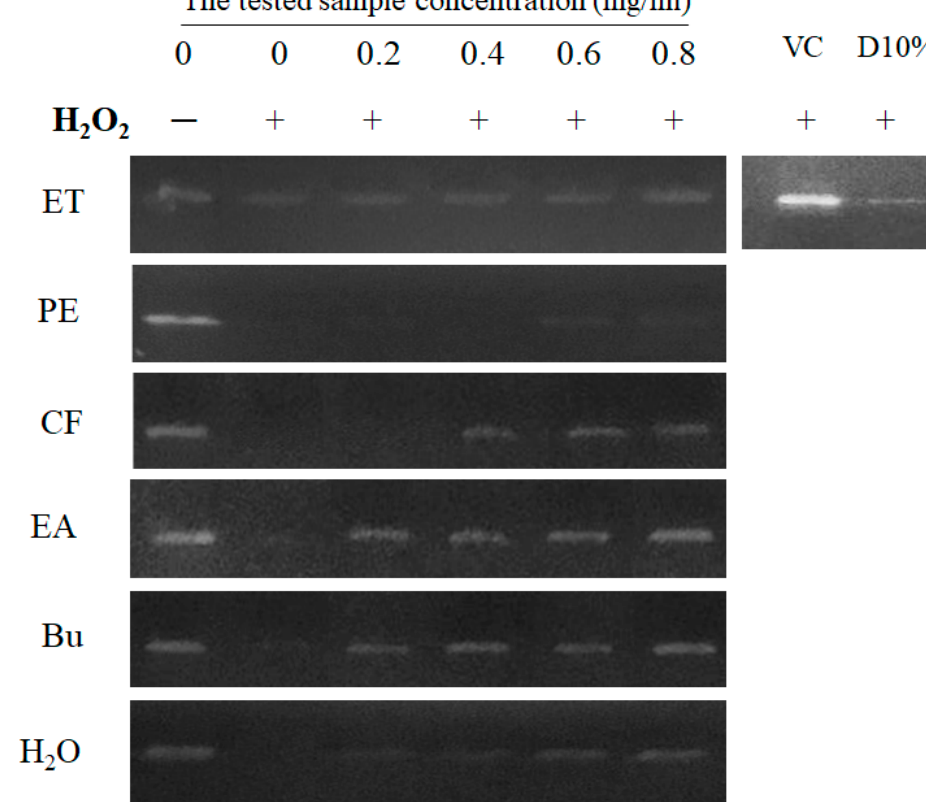
Figure 2. Protective effects of wild bitter melon extract and fractions against H 2 O 2 -induced DNA damage. Dimethyl sulfoxide (DMSO) 10% (D10%) was used as negative control, while vitamin C (VC) was used as positive control. “ + ” indicates the presence of H 2 O 2 , while “ − ” indicates the absence of H 2 O 2 . The control was exposed by H 2 O 2 without the tested sample, while the blank was absent both H 2 O 2 and the tested sample. Ethanol extract (ET), petroleum ether (PE), chloroform (CF), ethyl acetate (EA), n-butanol (Bu), and H 2 O fraction.